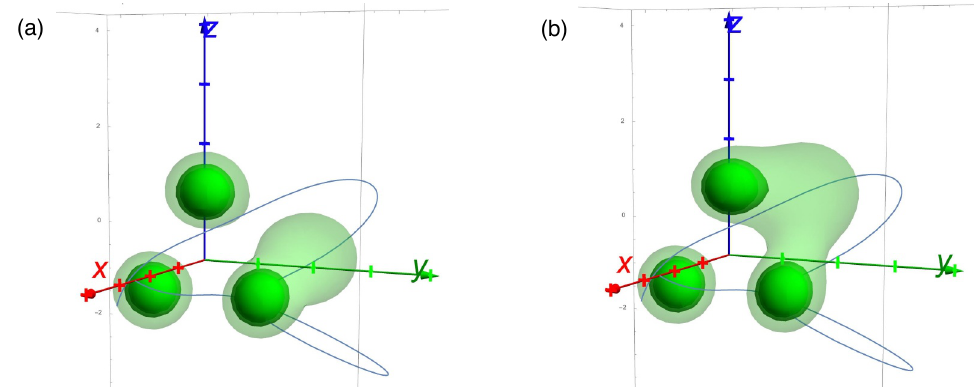
Figure 5 . Two frames from a simulation with q = 1 and C = 3 . The initial conditions are the same as in the previous example, and the trajectory has been evolved for the same τ The frames correspond to τ = 10 and τ = 15 . 2 for (a) and (b)